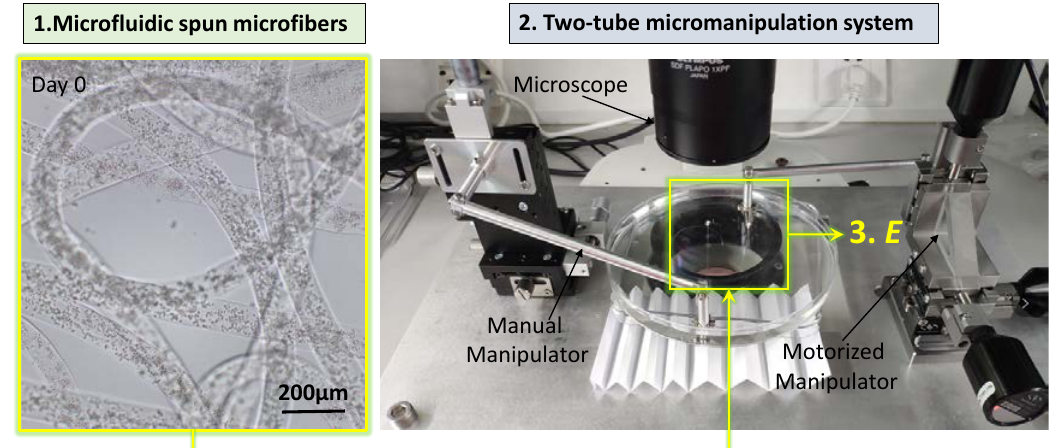
Figure 1. Measurement process. Cell-laden GelMA microfibers are first spun by microfluidic device, and the tow-tube micromanipulation system is utilized to measure the microfiber E .